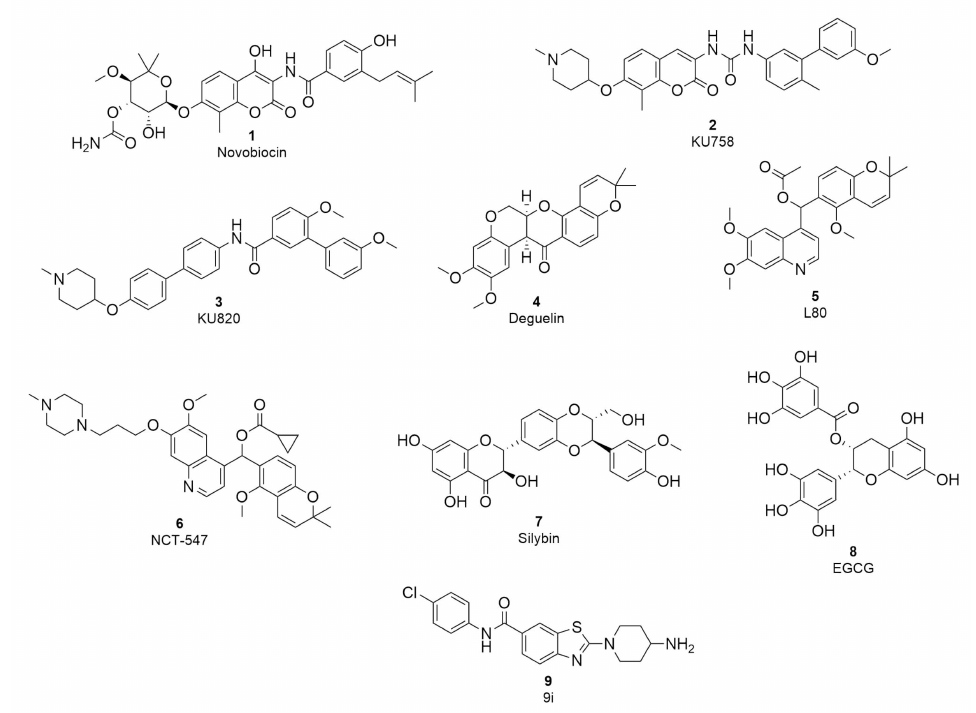
Figure 1. Representative structures of Hsp90 CTD inhibitors; novobiocin and analogues ( 1–3 ) [28,29], deguelin and analogues ( 4–6 ) [31,33], silybin ( 7 ), EGCG ( 8 ) and a benzothiazole-based inhibitor ( 9 )